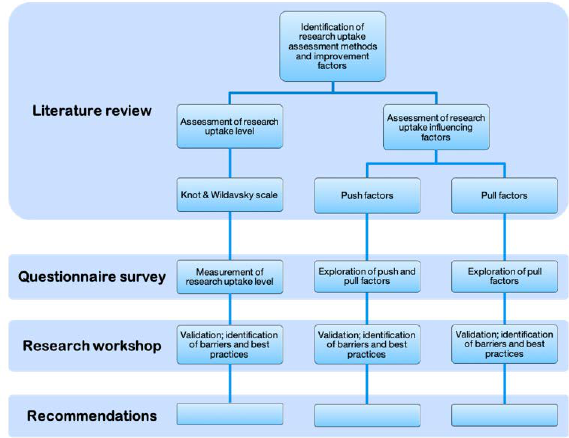
Figure 2. Research conceptual